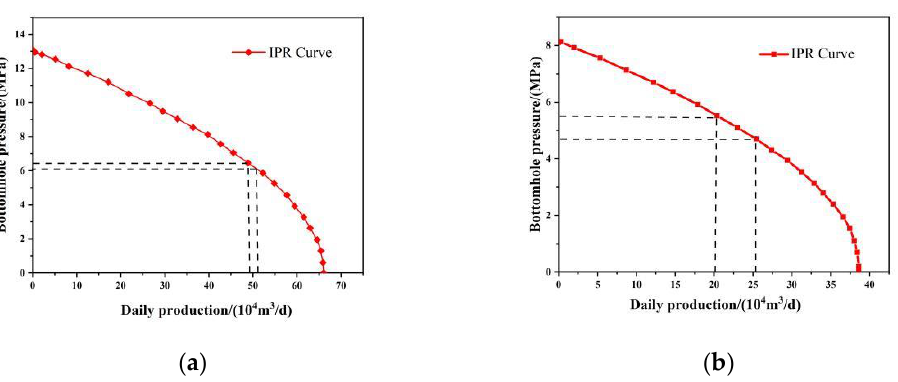
Figure 4. IPR curves of typical gas wells in the Changbei block. ( a ) Well CX-2. ( b ) Well CX-6.